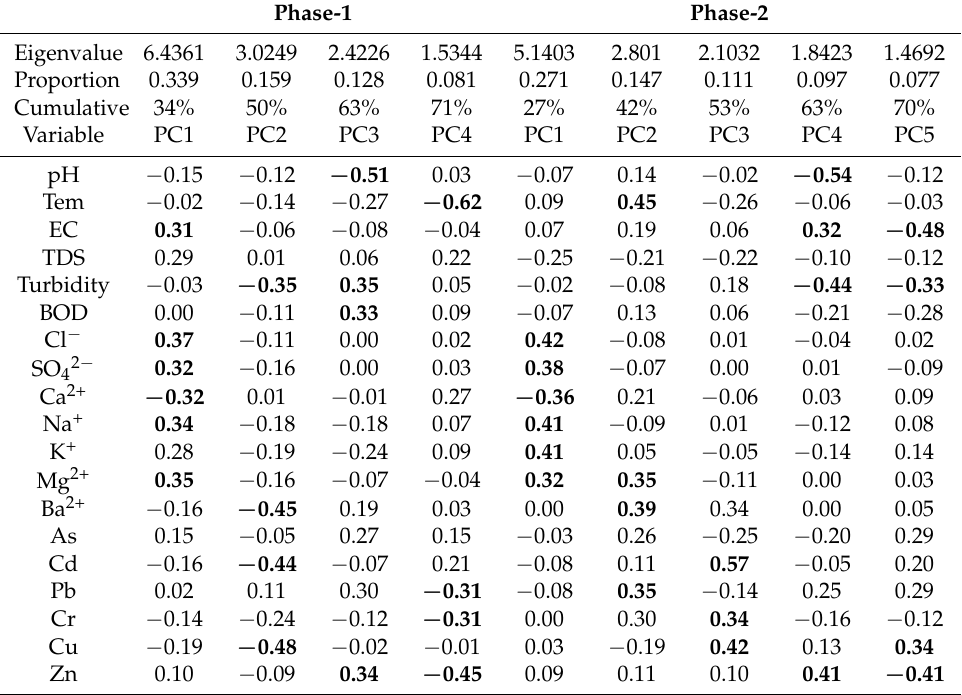
Table 2. Eigenvalues and principal components for phase-1 and phase-2